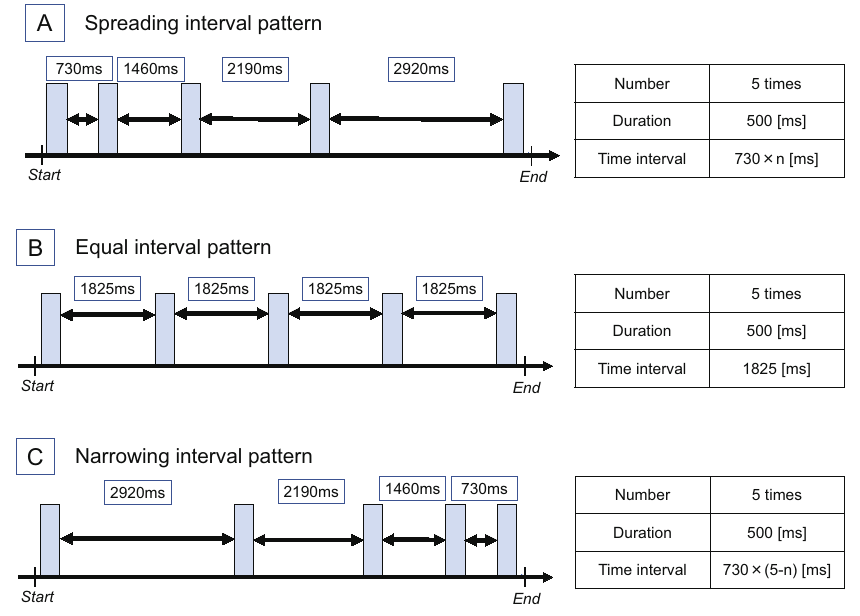
Figure 8. Stimulus pattern of Experiment 3. Three patterns with different time intervals of